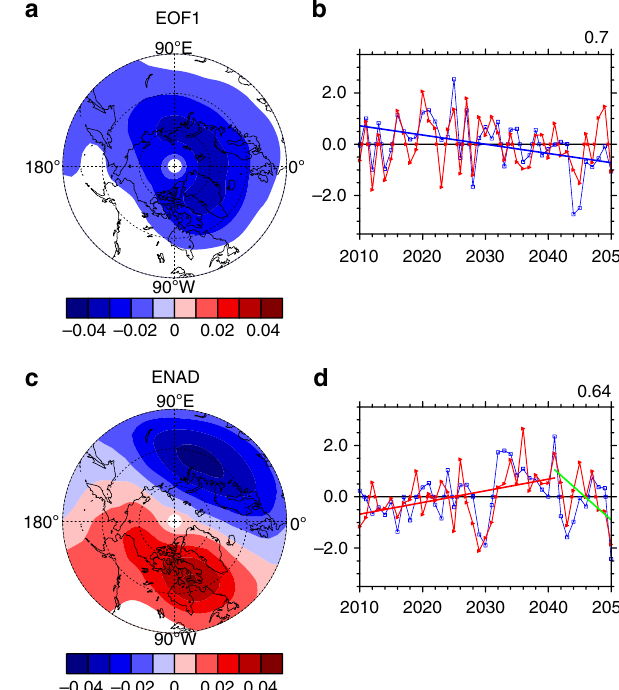
Fig. 5 Future changes in total column ozone and polar vortex. Spatial patterns of a EOF1 and c Eurasia-North America dipole (ENAD) mode, and time series of b principal component (PC) 1 (blue curved line) and d ENAD index (blue curved line) of multi-model mean total column ozone (TCO) in February, derived from the EMAC-L90MA, MRI-ESM1r1 and IPSL models, for the period 2010 – 2050. The red curved lines in b and d represent the polar vortex strength and shift index, respectively. The blue straight line in b represents the linear trend in PC1 during 2010 – 2050. The red and green straight lines in d denote linear trends in polar vortex shift index during 2010 – 2041 and 2041 – 2050, respectively. The correlation coef fi cient between PC1 and the vortex strength is shown in the top right of b , and correlation coef fi cient between ENAD index and the vortex shift index is shown in the top right of